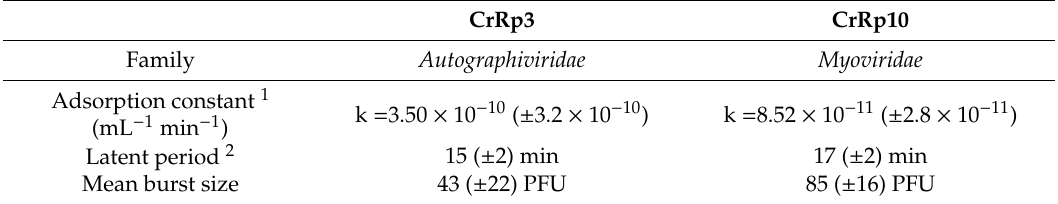
Table 2. CrPp3 and CrRp10 replication characteristics on C. rodentium strain